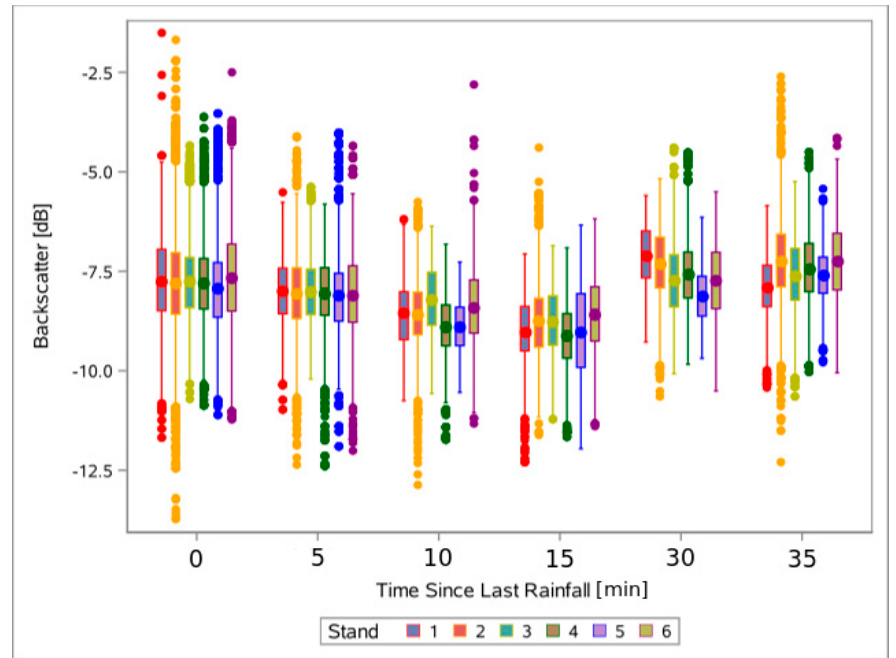
Figure 6. Least square mean of surface canopy water ( SCW ) plotted against time since the last rainfall.